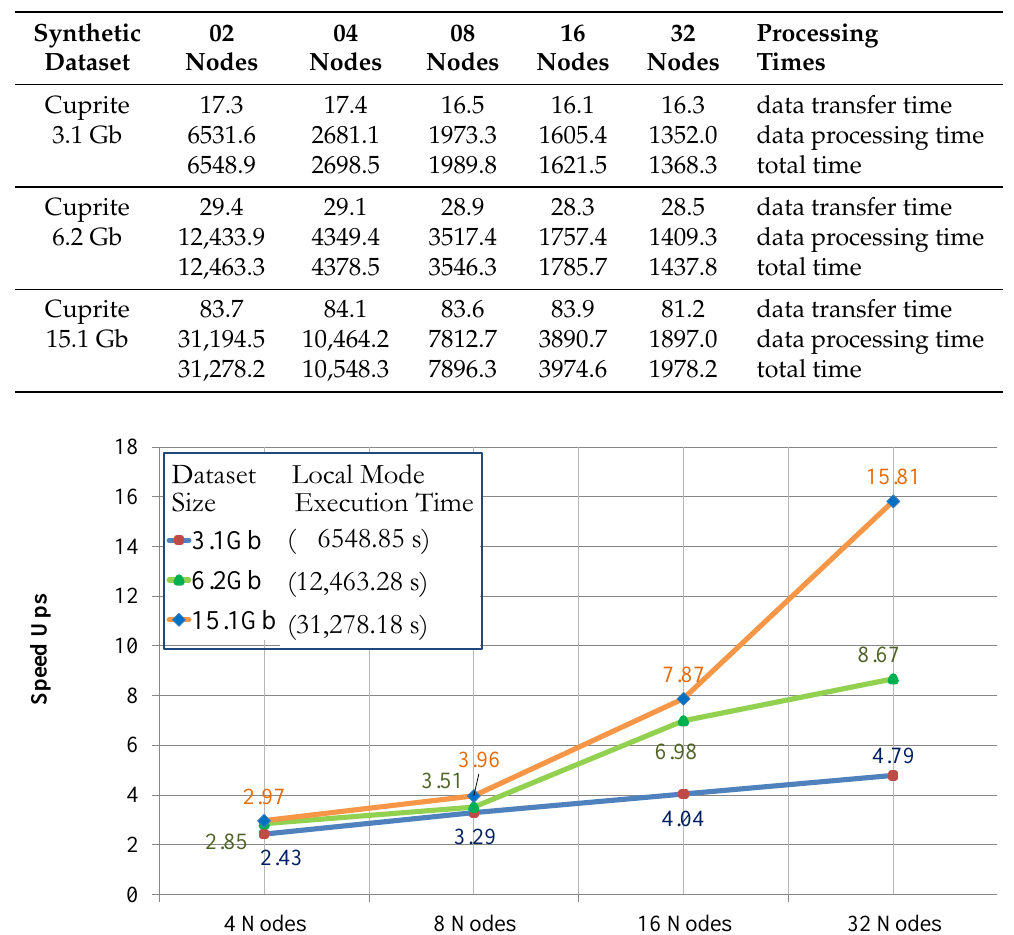
Table 3. Average processing times for each step of the endmember extraction process on the cloud environment (in seconds).